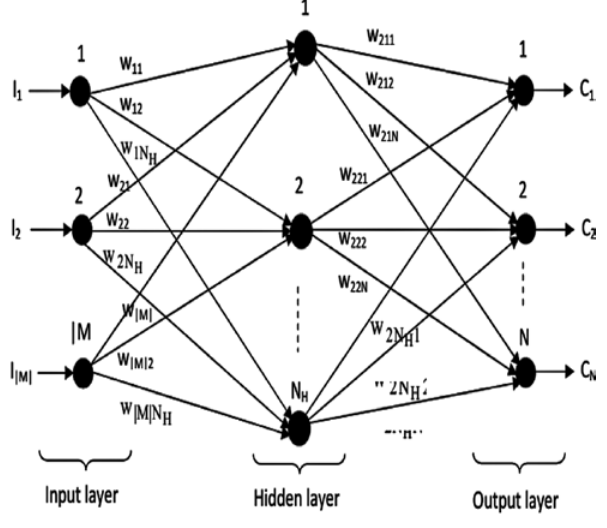
Figure 2: Structure of the